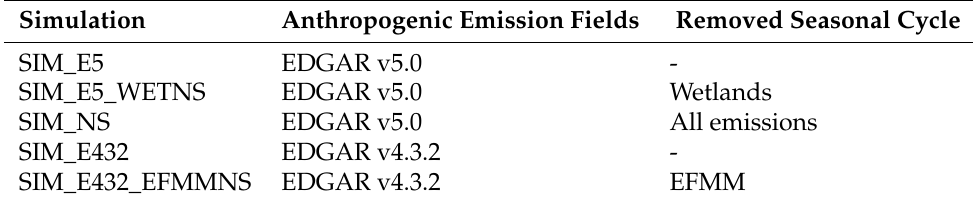
Table 4. Set of simulations, anthropogenic emission fields used, and emission categories from which seasonal cycle is removed. The sources for natural emissions are shown in Table